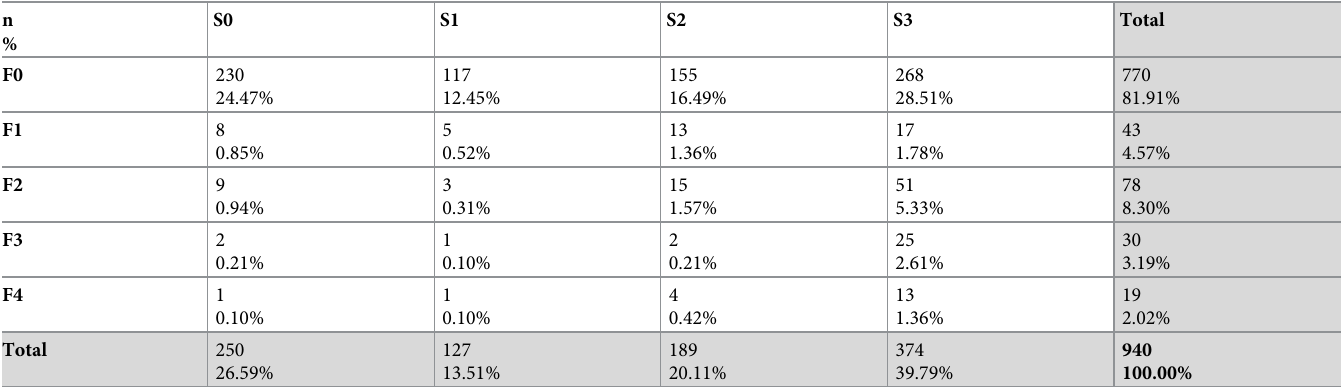
Table 5. Steatosis and fibrosis score distribution.